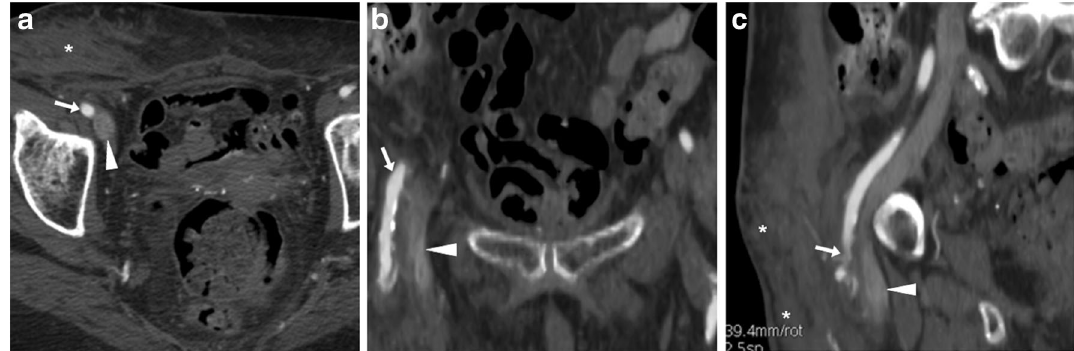
Fig. 7 Arterio-venous fistula (AVF) observed 24 h after CA: multiplanar CT-angiographic images showed subcutaneous haematoma (*) and simulta- neous opacification of the CFA (arrows) and adjacent femoral vein (arrowheads) consistent with